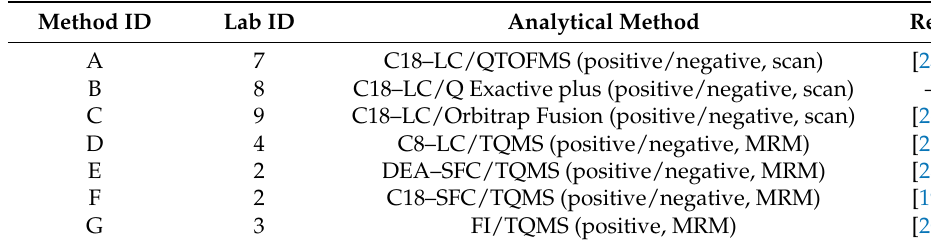
Table 2. Analytical methods for the hydrophobic metabolites.